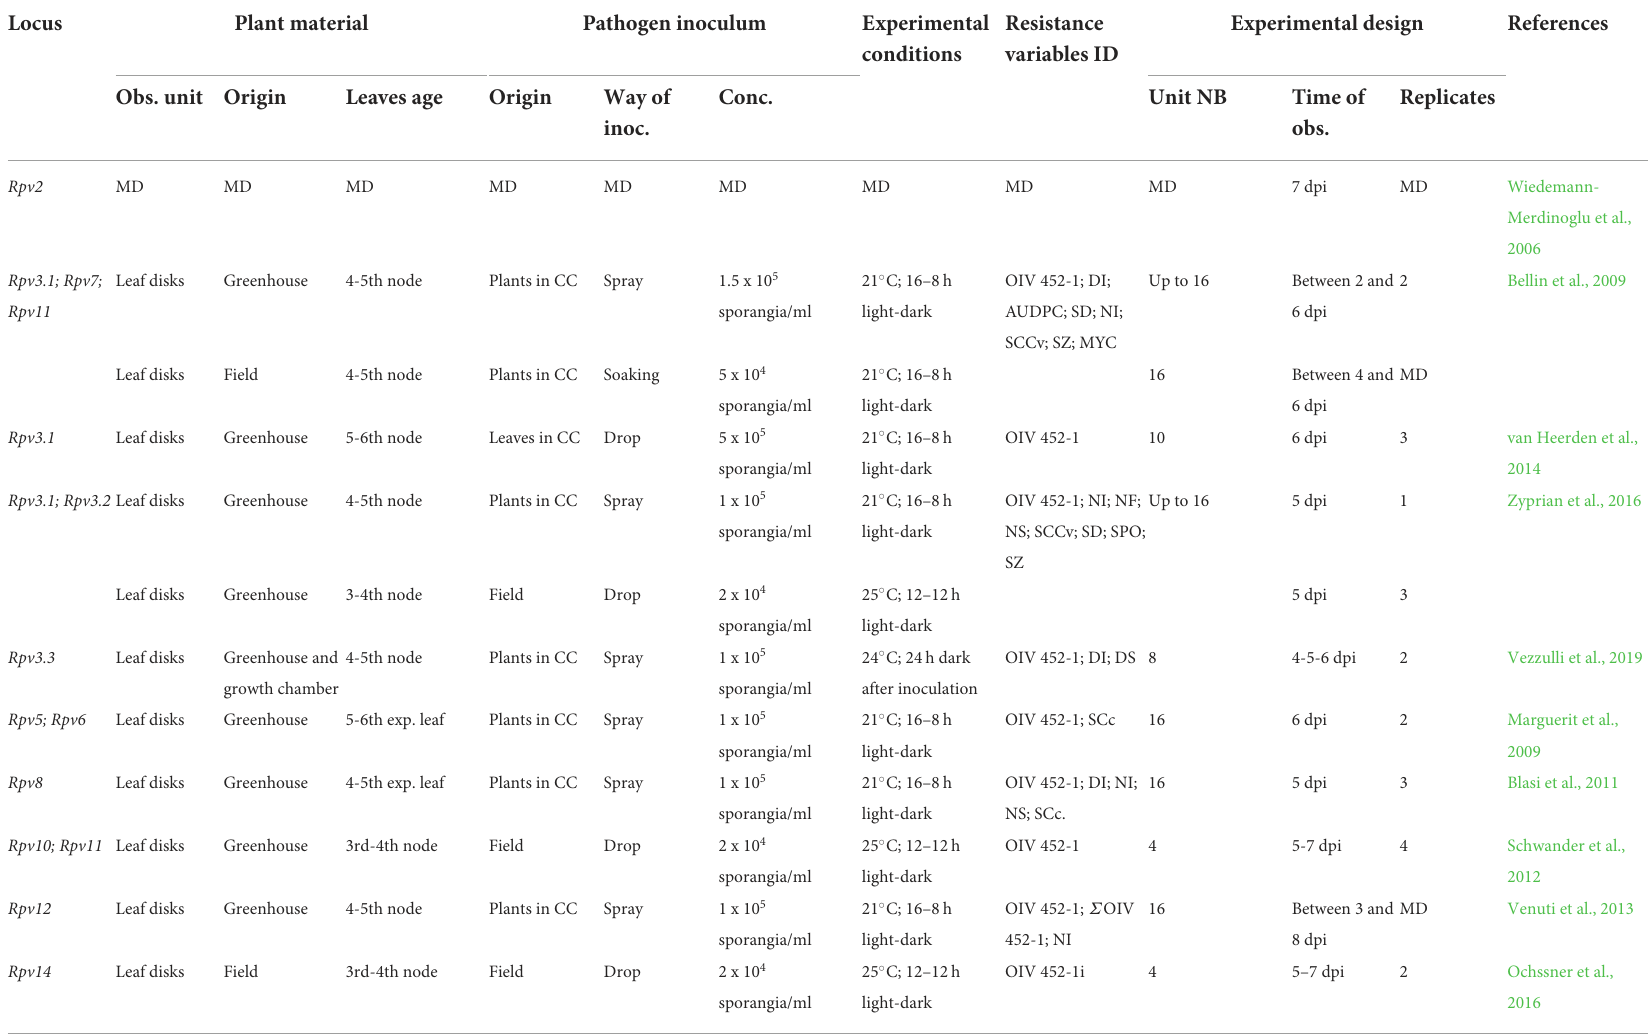
TABLE 7 Resistance phenotyping strategies utilized in the laboratory. The main elements and possible sources of variation of phenotyping protocols adopted in the main mapping studies are reported for each Rpv and Ren/Run locus.